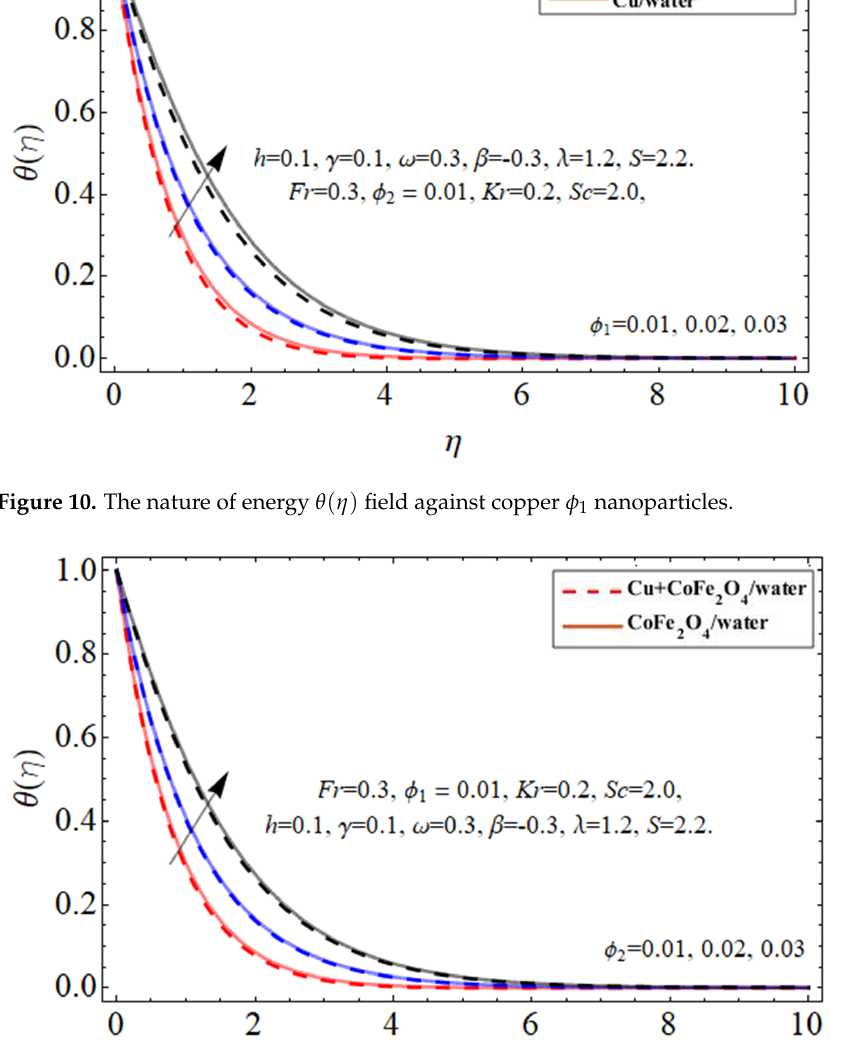
φ φ nanoparticles. Figure 11. The nature of energy θ 2 nanoparticles.